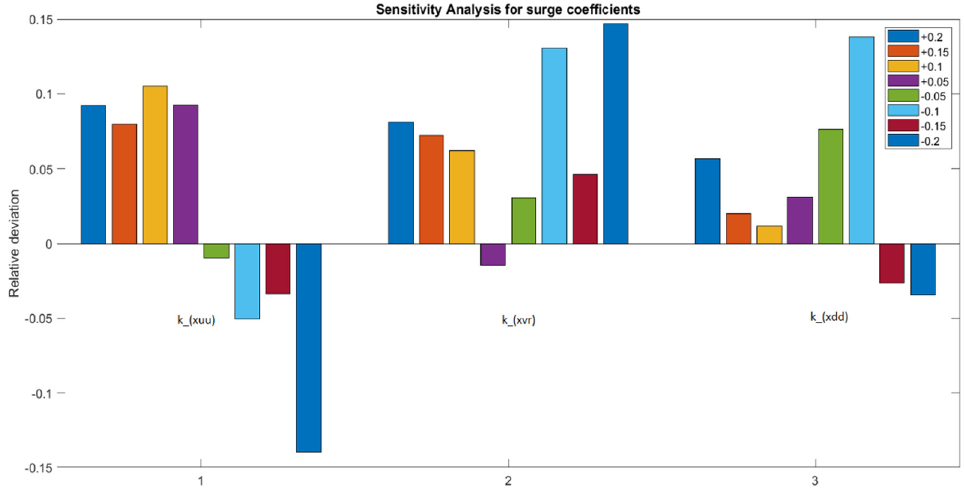
Figure 15. Sensitivity analysis for surge coefficients.